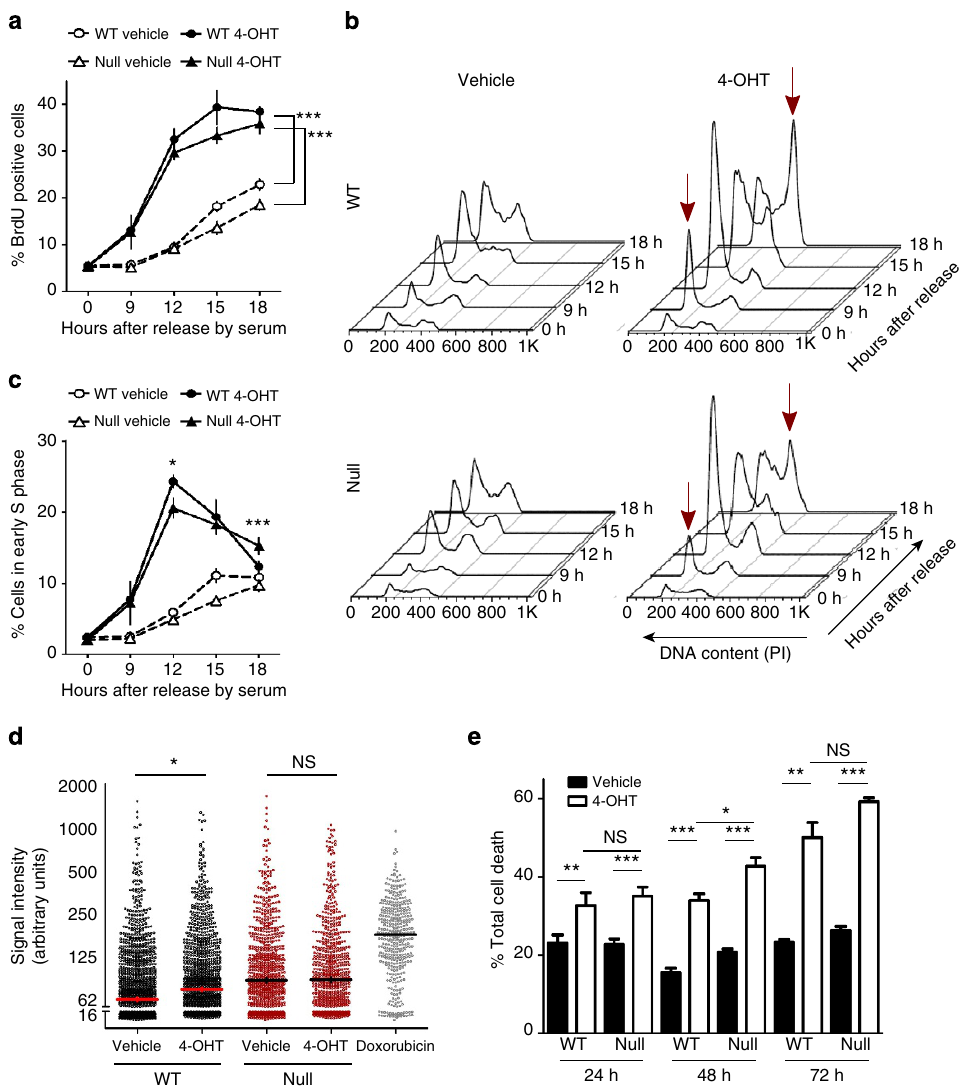
Figure 4 | Bptf is required for MYC-induced proliferation of MEFs and replication stress but not for apoptosis. ( a ) WT ( n ¼ 4) and Bpft -null ( n ¼ 4) MEFs transduced with MYC-ER were seeded at high density, arrested with 0.5% FBS for 48h and stimulated with serum in the presence/absence of 4- OHT. At the indicated time points, cells were pulse labelled with BrdU for 1h before collected. Data are represented as mean ± s.e.m. *** P o 0.001 (paired t - test). ( b ) Histograms depicting the ploidy of BrdU-positive cells throughout the experiment described in a . ( c ) Quantification of early S-phase cells. The rate of loss of BrdU þ early S-phase cells represents S-phase progression. Data are represented as mean ± s.e.m. * P o 0.05; *** P o 0.001 (unpaired t -test). ( d ) Replication stress—intensity of g H2AX signal in WT and Bpft-null MYC-ER MEFs ( n ¼ 3 per group) in the presence or absence of 4-OHT for 48h. Doxorubicin-treated cells were used as control. * P o 0.05 (paired t -test) ( e ) WT ( n r 4) and Bpft -null ( n r 4) MEFs expressing MYC-ER were seeded at high density and then transferred to 0.5% FBS with or without 4-OHT (2 m M). Apoptosis was measured as the proportion of Annexin V-postivive cells at the indicated time points. * P o 0.05; ** P o 0.01; *** P o 0.001 (paired t -test to compare vehicle versus 4-OHT; unpaired t -test to compare WTversus Bptf -null